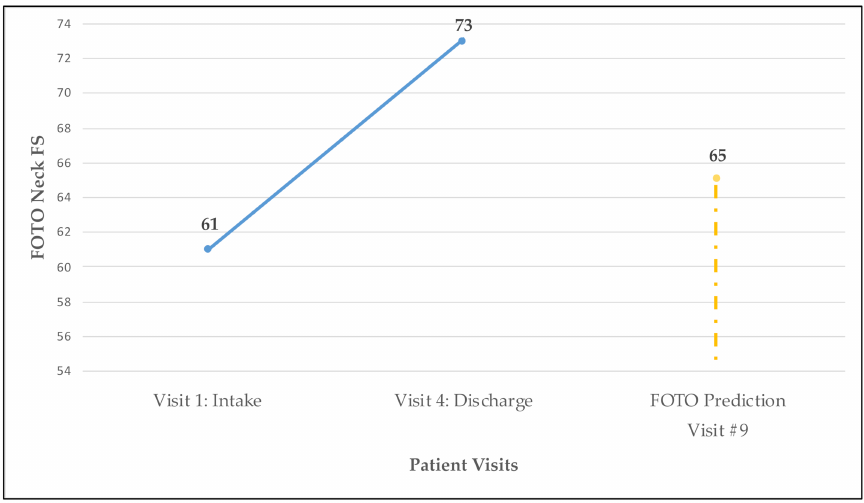
Figure 4. FOTO Neck FS outcomes from intake to discharge. Abbreviations: FOTO, Focus On Therapeutic Outcomes; FS, functional